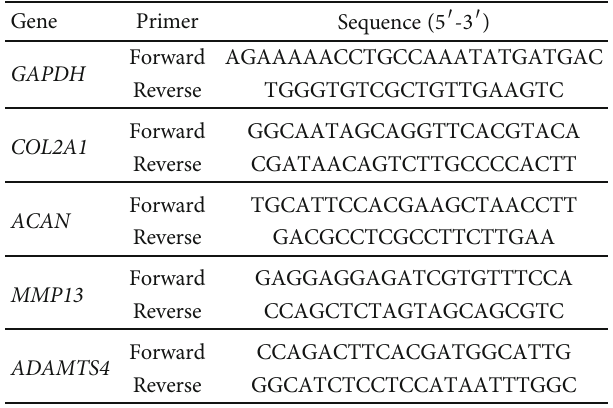
Table 1: Primers used for real-time quantitative PCR. Gene